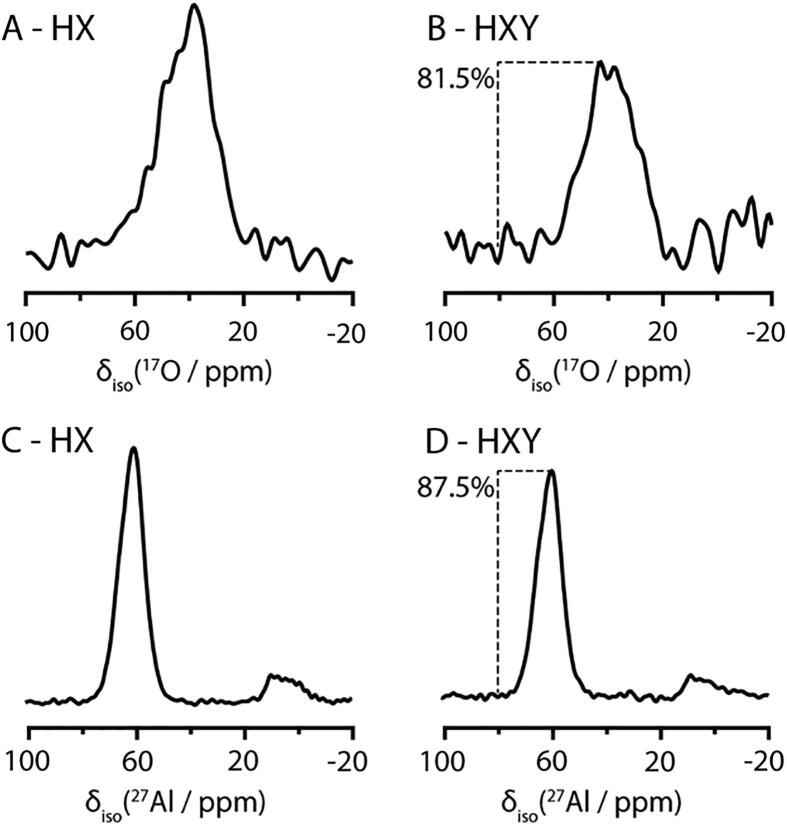
3Q MQMAS filtered (t1 = 0) NMR efficiency comparison for 17O (A,B) and 27Al (C,D) in a NASH glass gel 1.18Na2O•5SiO2•Al2O3 glass between double resonance (HX, A and C) and triple resonance (HXY, B and D) on a spectrometer operating at 700.1 MHz 1H frequency, with spinning rate of 20 kHz, where 2048 transients were collected for 17O (A,B) and 4096 transients were collected for 27Al (C,D). The signal intensity of the triple resonance experiments compared to the identical experiment by overlay is indicated in B and D.